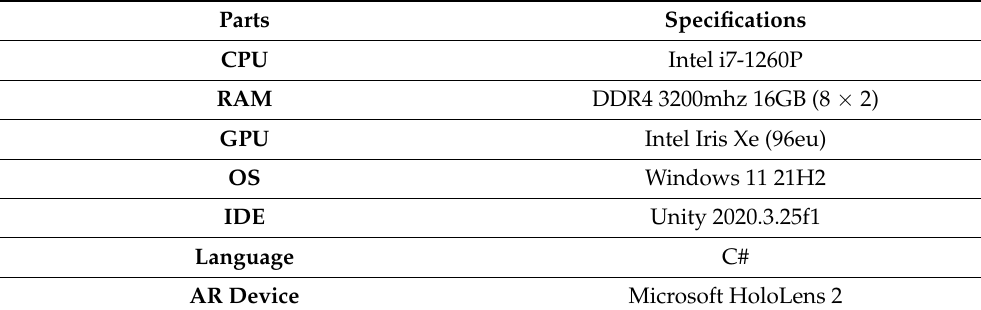
Table 1. System Table 1. System environment.